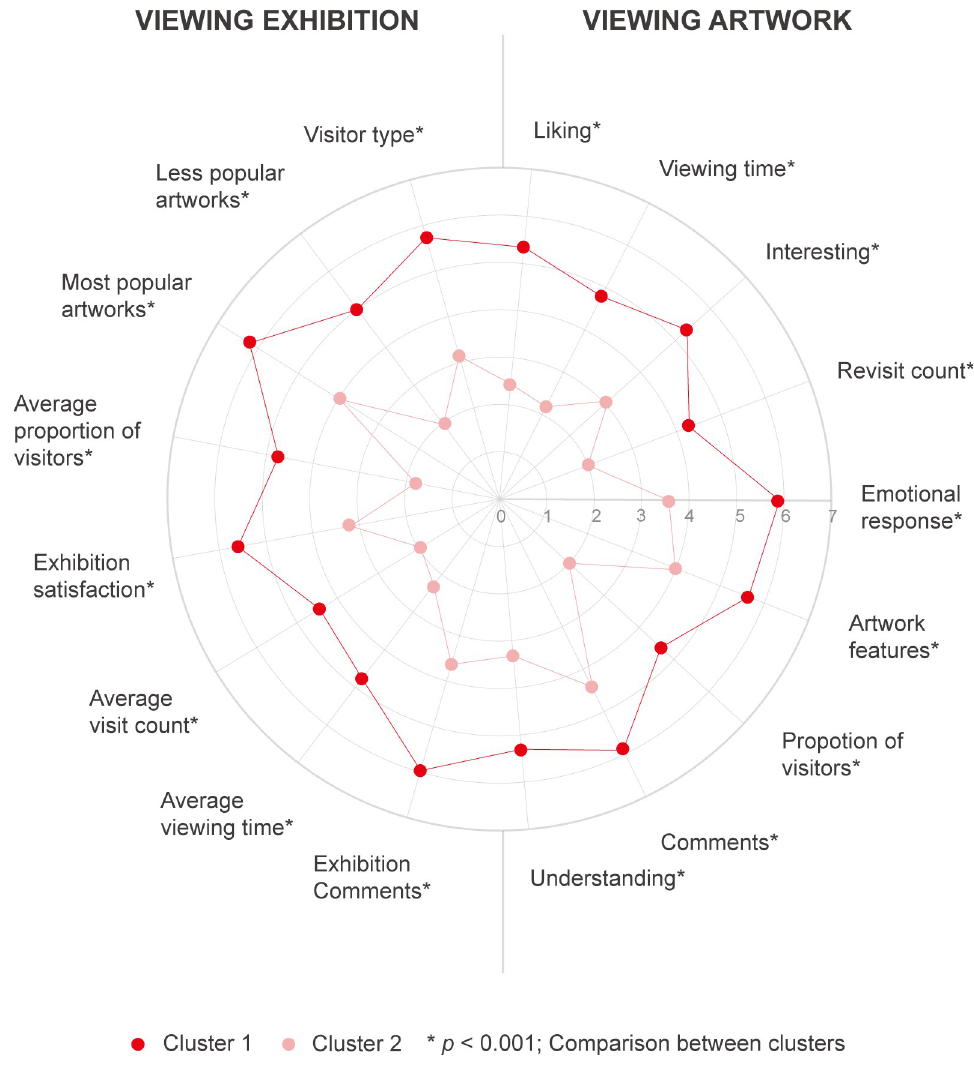
Fig 5. Results of k-means clustering through an online survey